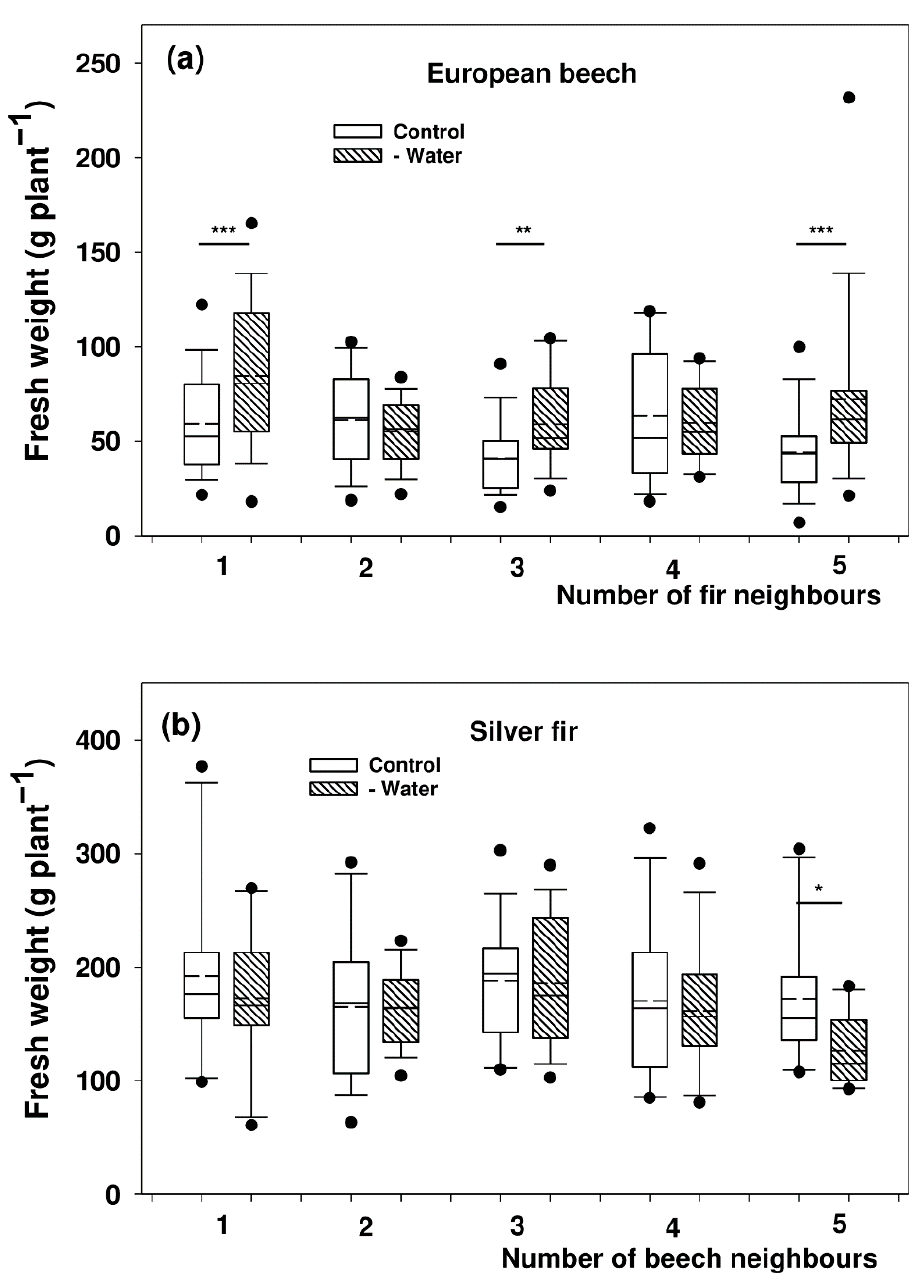
Figure 2. Fresh weight of European beech ( a ) and silver fir ( b ) after two years of growth in mixed cultivation as dependent on the number of inter-species neighbors. -Water: Beech/fir mixtures ex- posed water deprivation and rewatering during the first year of growth. Data shown are means ± SD (beech: n = 15–16; fir: n = 8–30). Significant differences between control and -Water are indicated by asterisks (*, p < 0.05; **, p < 0.01; ***, p < 0.001).